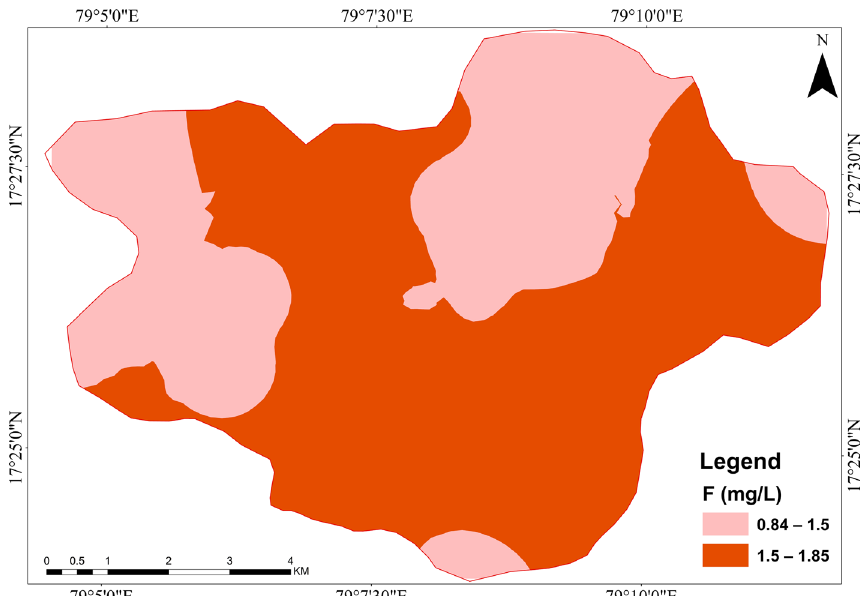
Fig. 13 Spatial distribution map of F − in Mothkur region, Telan- gana State, South